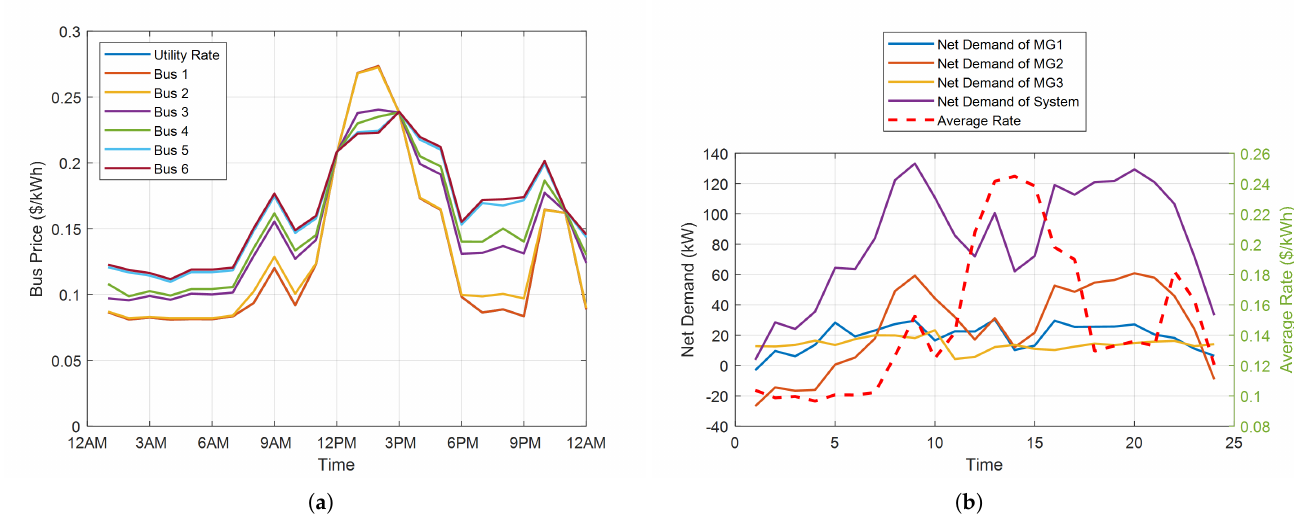
Figure 7. Calculated bus prices and system net demands in grid-connected mode. ( a ) Bus Price. ( b ) System Net